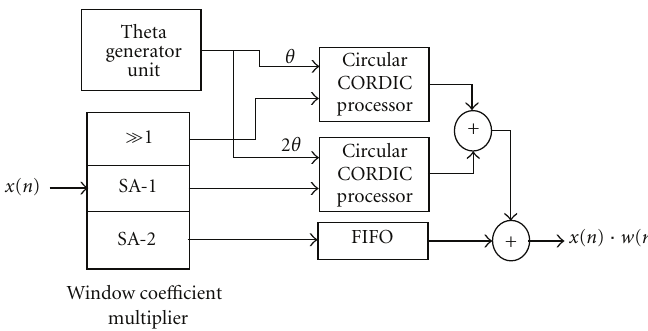
Figure 3: Block diagram for generating blackman window function.